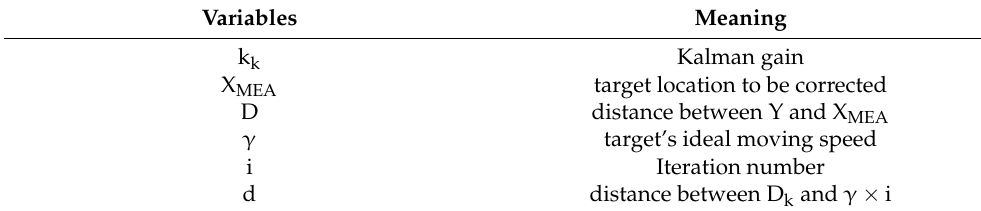
Table 1. Cont. Variables